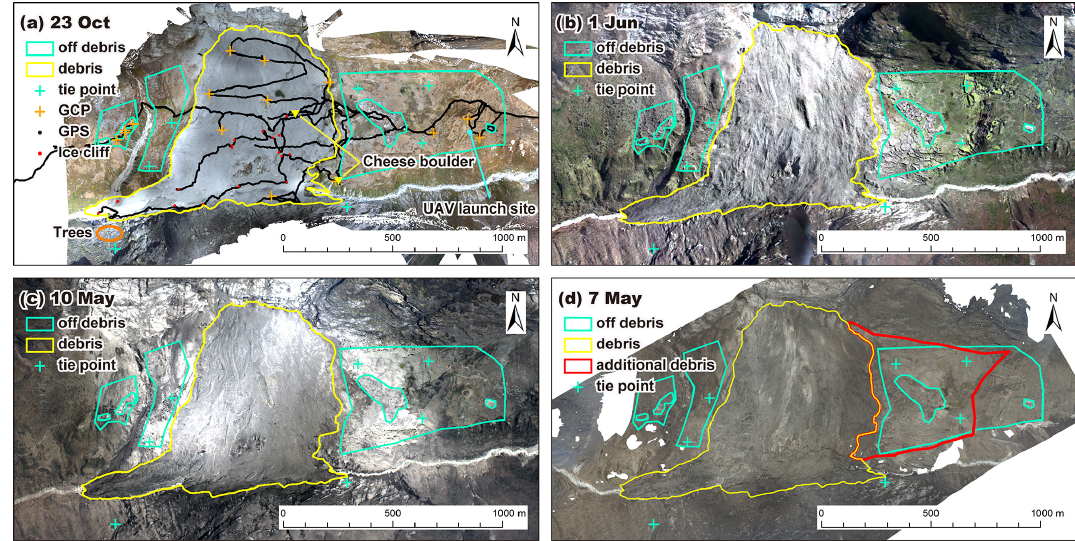
Figure 2. Orthomosaics over the Langtang village on (a) 23 October, (b) 1 June, (c) 10 May, and (d) 7 May 2015. Because the GPS measurement was conducted at 1s interval, the GPS points look like black lines in (a) . Table 1. Camera and lens properties of UAV and helicopter photographs and resolution of the structure from motion (SfM) products. Date Camera Focal length a Pixels n b Resolutions (m) c